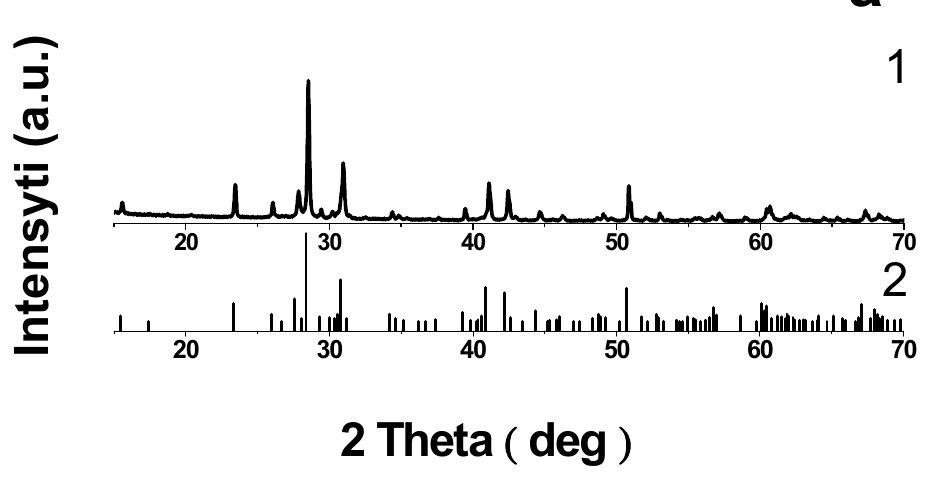
Figure 2. Raman spectrum for Li 3.8 Ge 0.9 S 0.1 O 4 across the wavenumber range of 50–1200 cm − 1 ( 1 ) and 50–4000 cm − 1 ( 2 ).